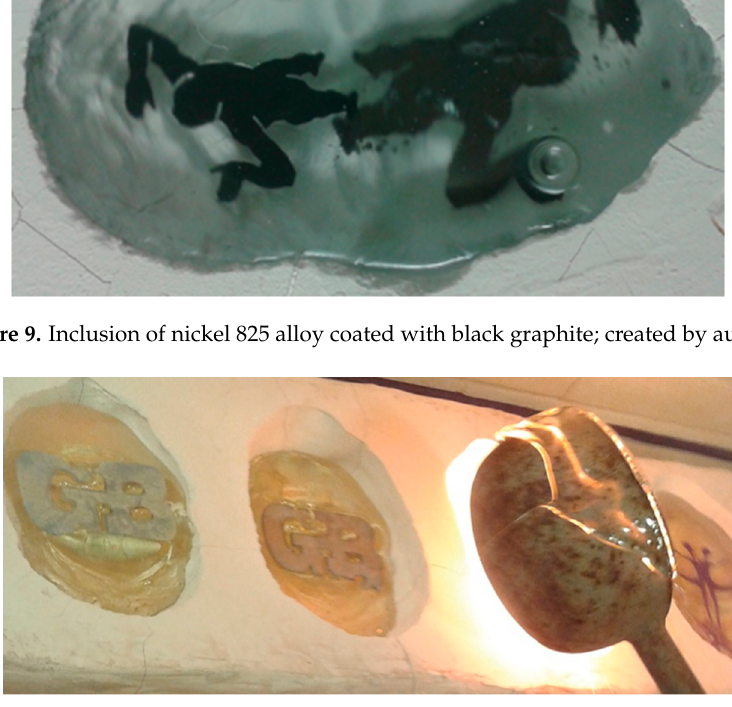
Figure 10. Method of pouring hot glass into plaster molds. The high temperature resistant moulds, up to 900 °C; created by author.